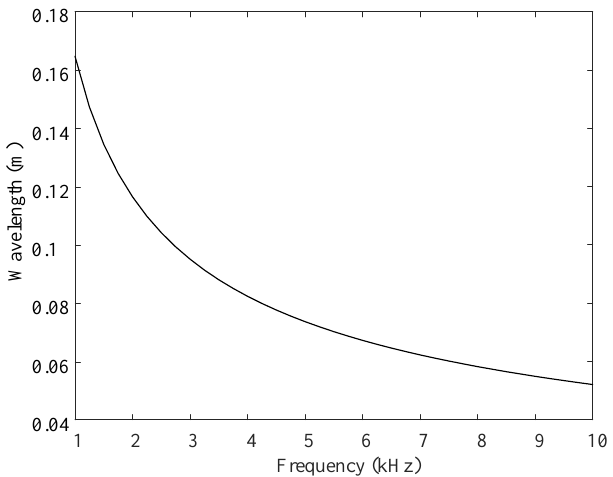
Figure 6. The relationship between wavelength and excitation frequency ( η 2 = 0.8, h 2 = 0.002 m).